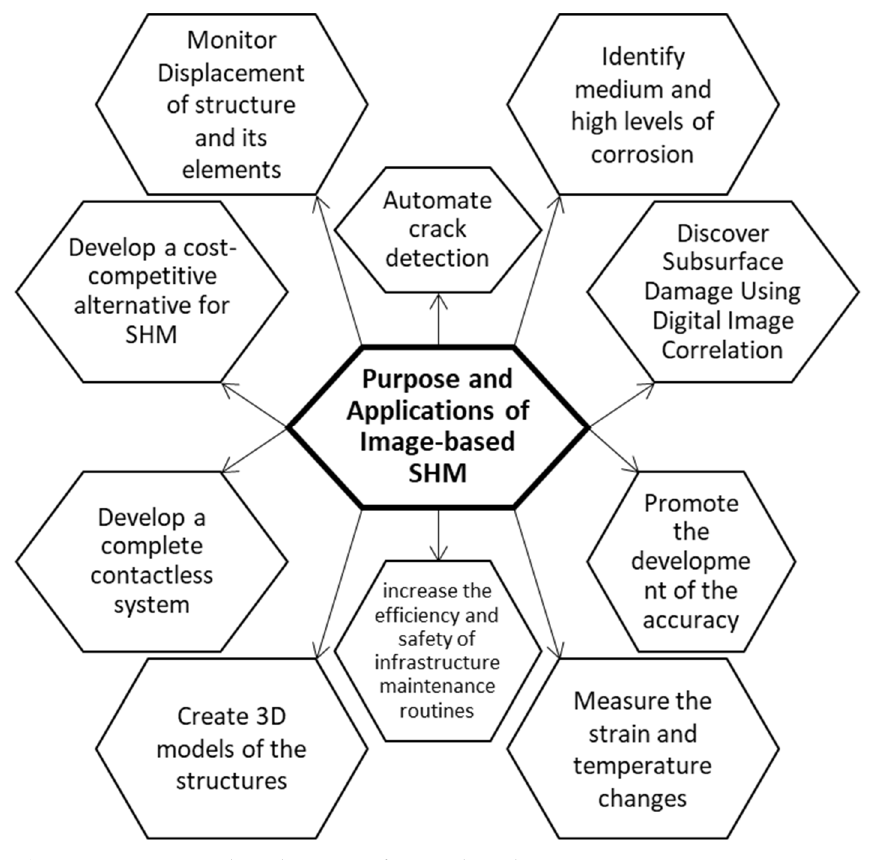
Figure 2. Purpose and applications of image-based SHM.